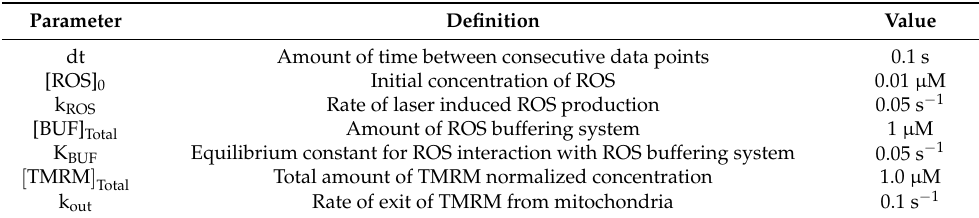
Table 1. Parameters in Computational